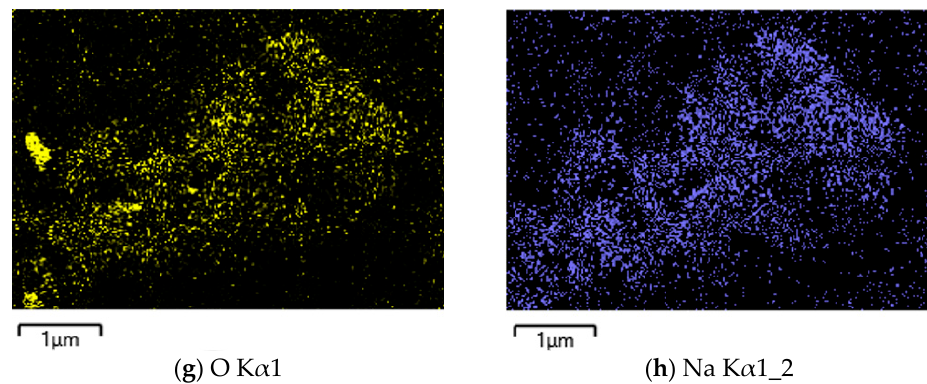
Figure 7. ( a ) SEM micrograph of the raw reaction product of CdSe NPs with H 3 L (as carboxylate sodium salt). ( b – h ) EDX mapping pattern of different elements: Cd, Se, C, N, O, S, and Na.